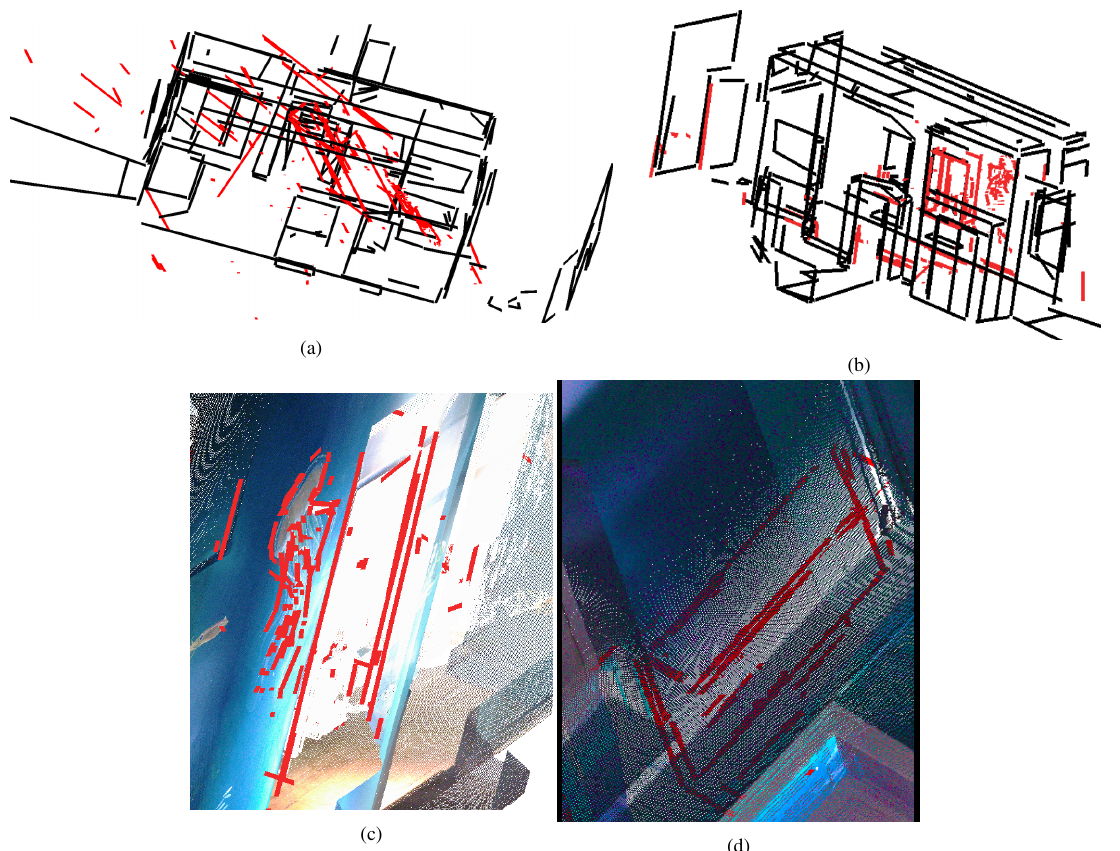
Figure 5. image / LiDAR registration results: (a) position of the two line clouds before registration( red:image lines, black LiDAR lines),(b) position of the two line clouds after registration, (c) LiDAR scan, ((d,e)registration of image lines and the LiDAR scan